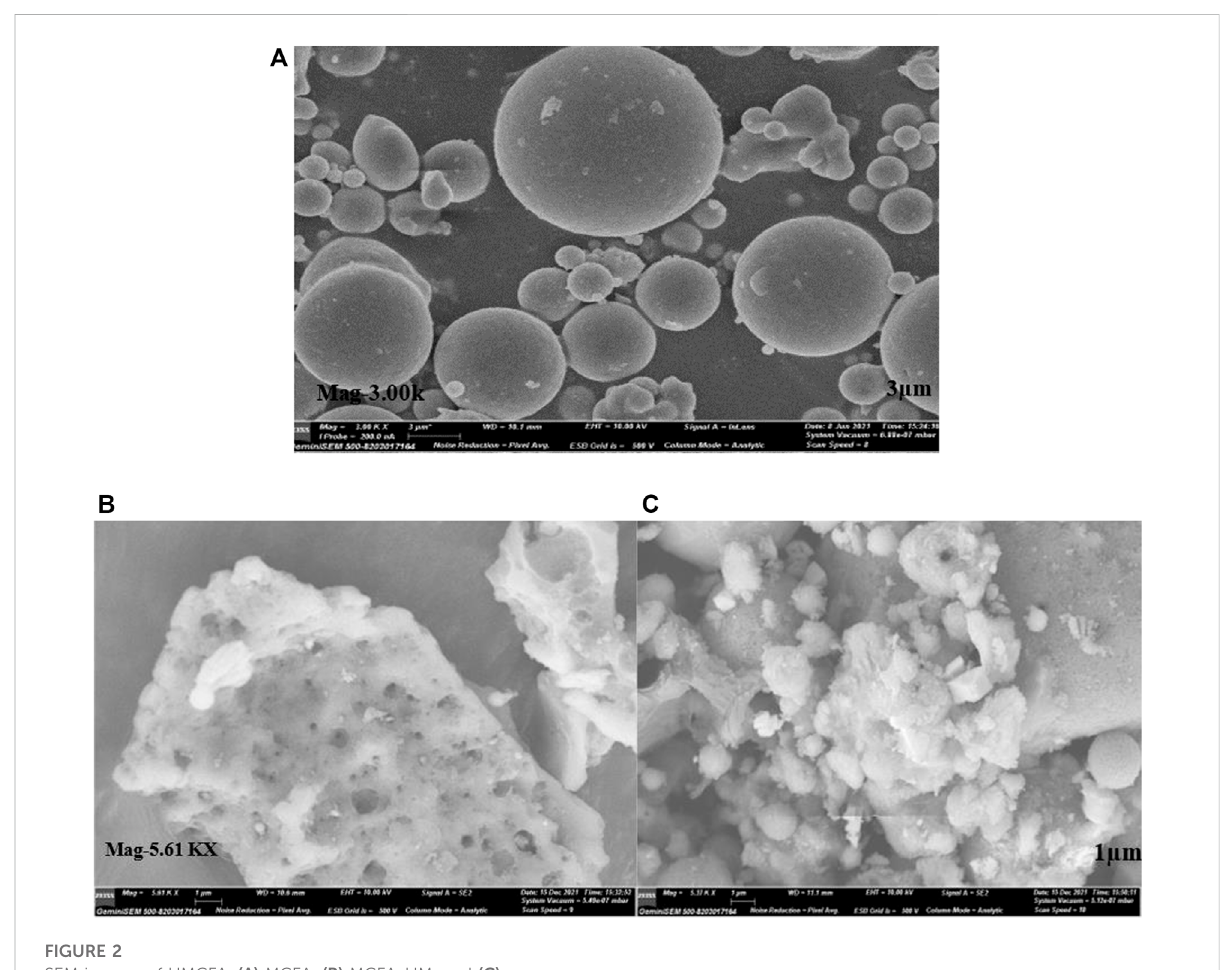
FIGURE 2 SEM images of UMCFA, (A) MCFA, (B) MCFA-HM, and (C)